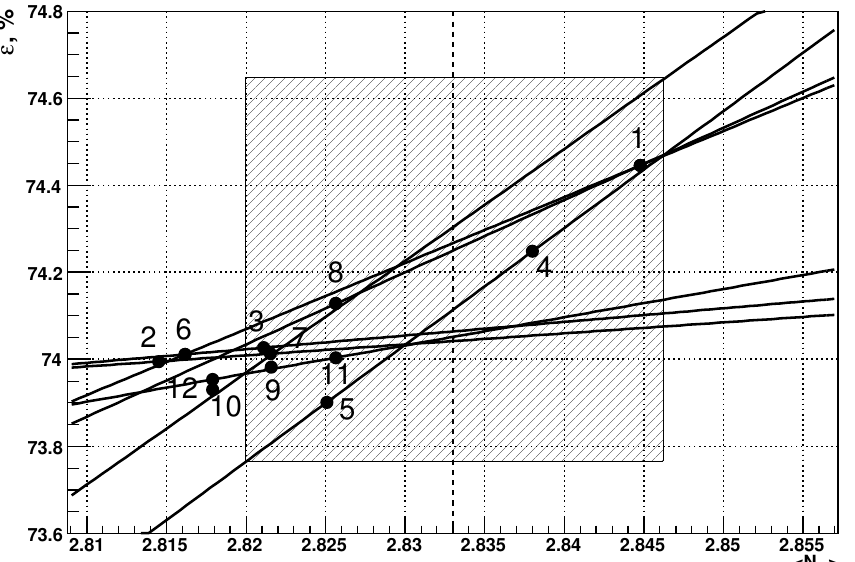
Figure 6 . Detection e(cid:14)ciency dependence on charged multiplicity for di(cid:11)erent versions of the J= decay simulation. The solid lines correspond to variation of the selected parameters. The dotted line corresponds to the experimental measured charged multiplicity and the rectangular shadow box shows its statistical error. The vertical limits of the shadow box correspond to (cid:12)t lines crossing the data statistical